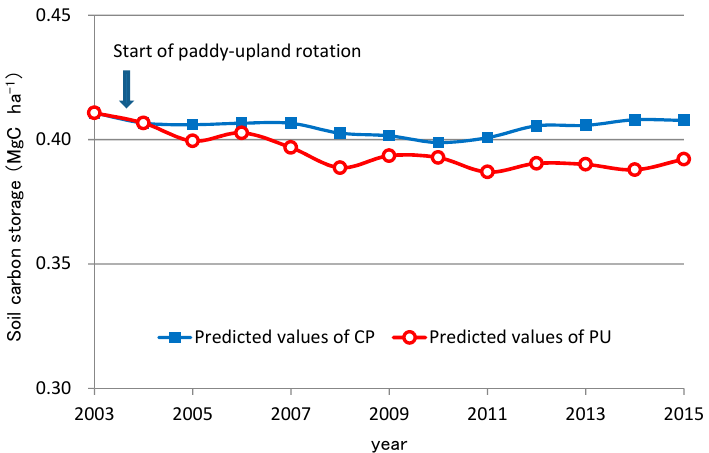
Figure 2. Estimation of the changes in the amount of soil carbon by RothC model.